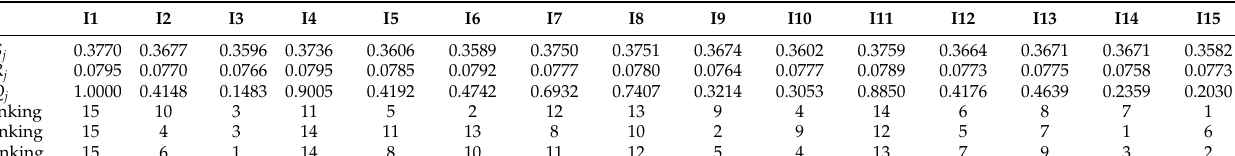
Table 16. Ranking results of I4Es.